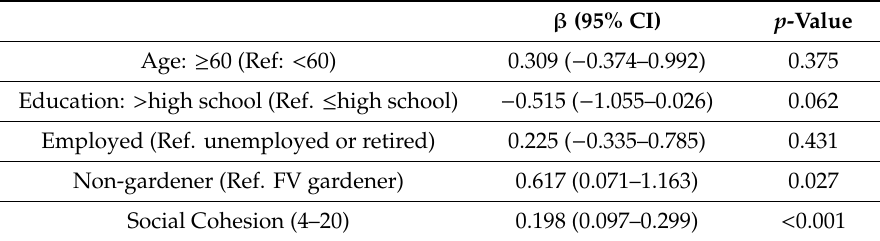
Table 1. Relationship with FV receiving frequency (Survey